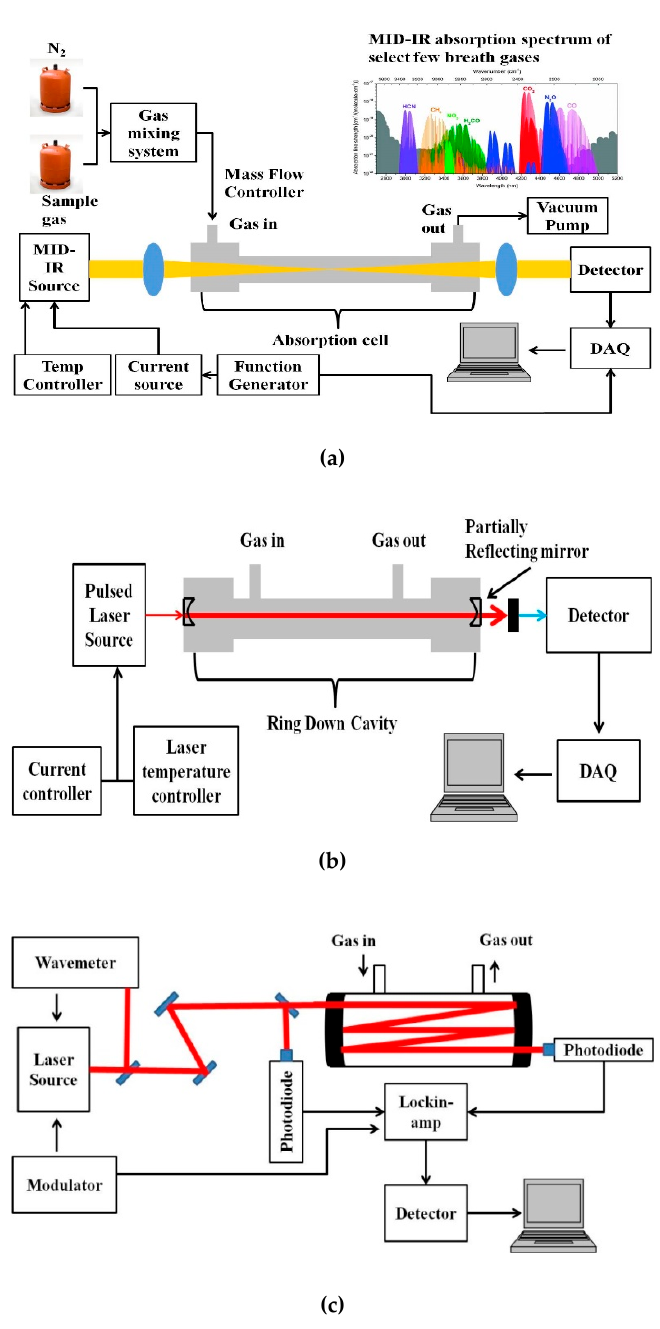
Figure 2. Simplified schematic of ( a ) mid-infrared (MIR) absorption spectroscopy, ( b ) cavity ring-down spectroscopy (CRDS), and ( c ) multi-pass spectroscopy (MUPASS). (DAQ: Data Acquisition system).